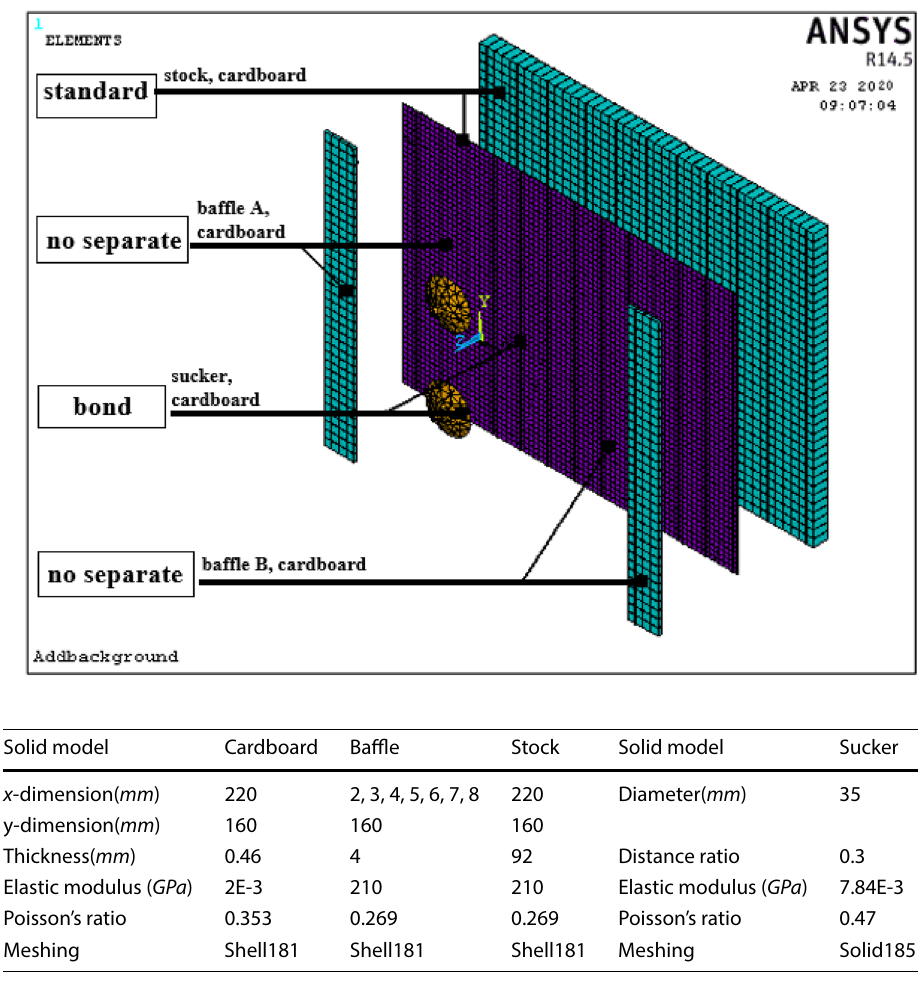
Fig. 3 Model of the simula- tions